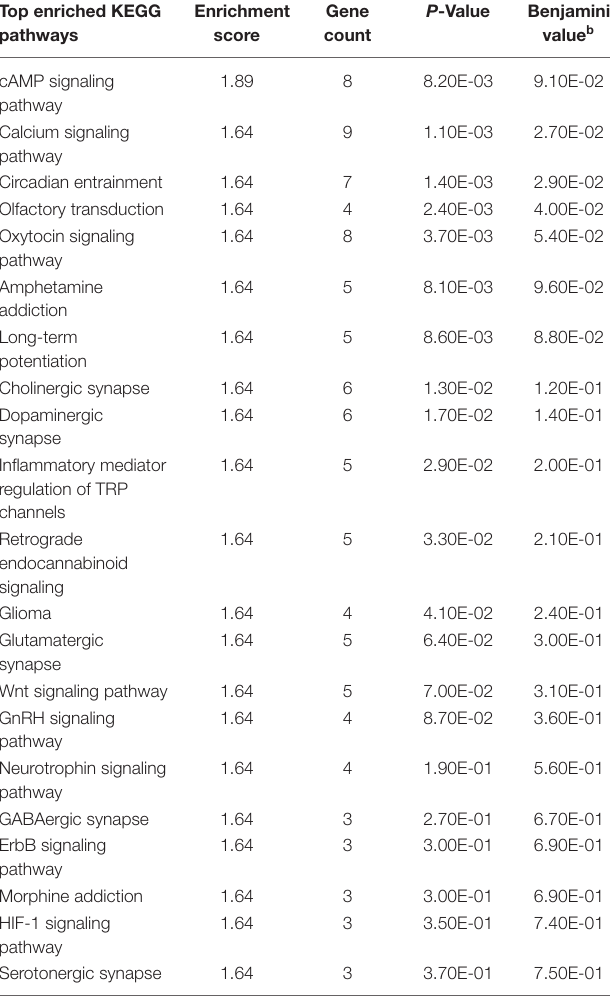
TABLE 7 | Pathway analysis of select up-regulated genes due to SGA in the hippocampus of 2 week-old piglets a . Top enriched KEGG